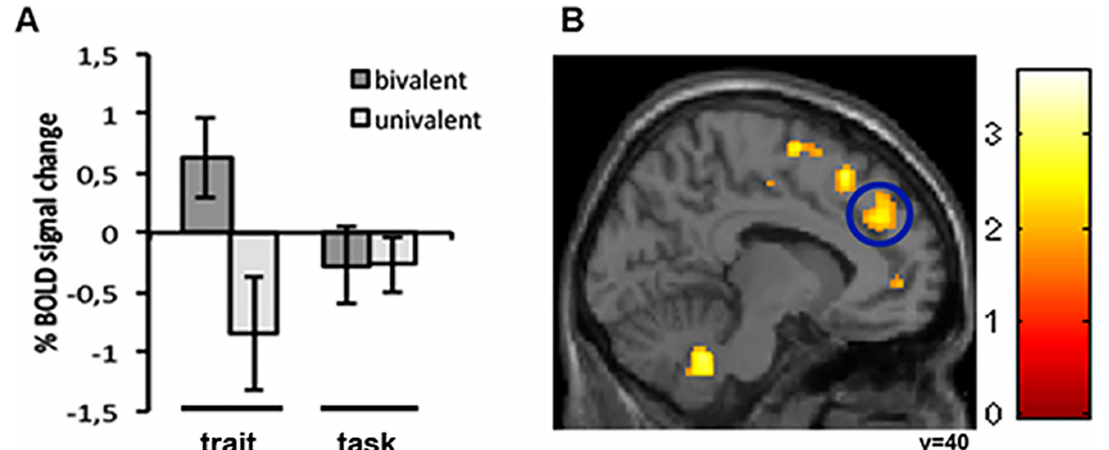
Fig 4. Brain activation in anterior paracingulate cortex when seeing rule symbols. A) % BOLD signal change for each condition and rule type. B) Activity increased in the trait condition compared to task